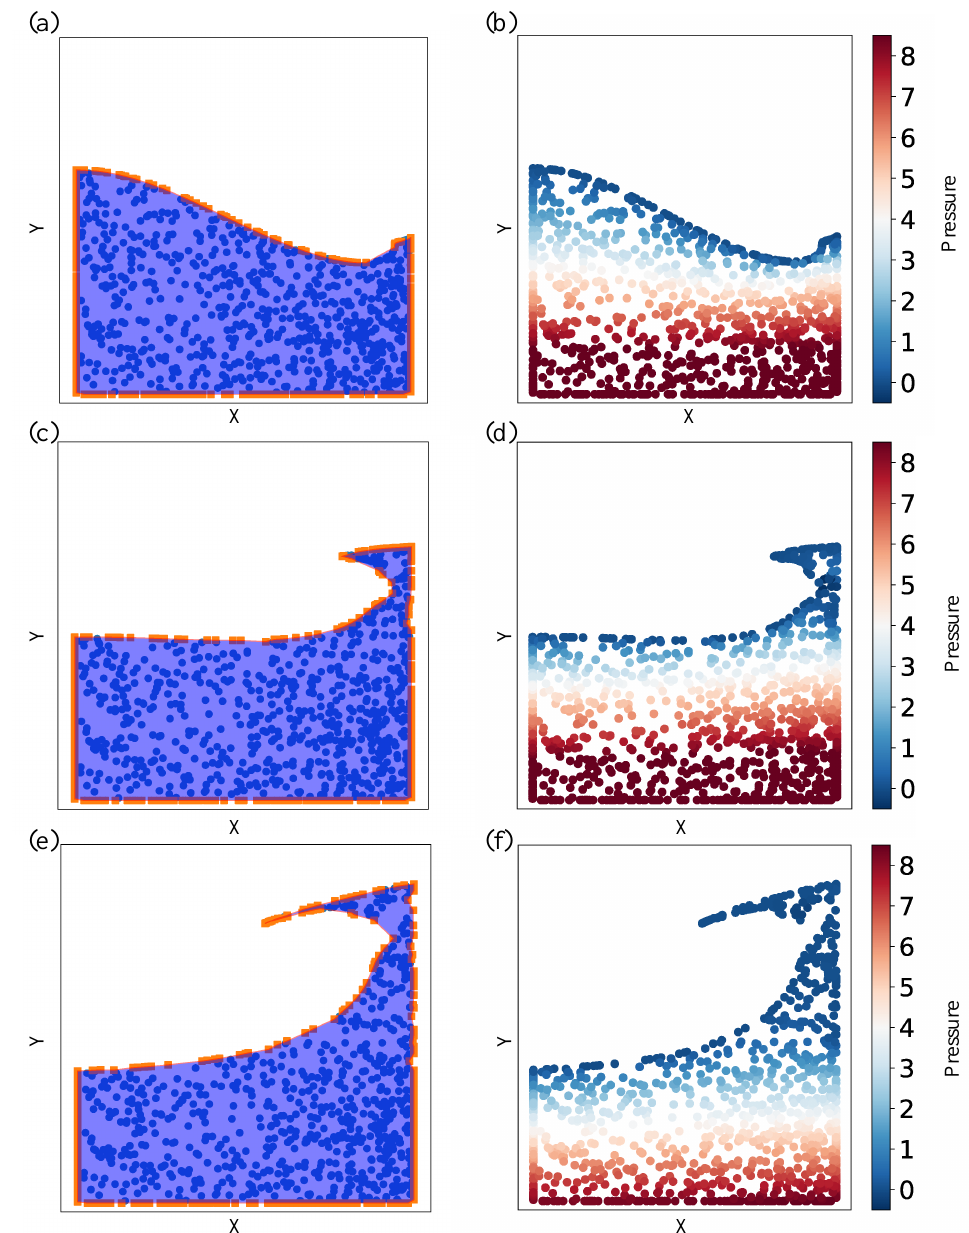
Figure 7. Surface particle identification and pressure field for violent sloshing with randomly distributed particles using the improved NPM. Simulation results at ( a , b ) t = 0.2 s; ( c , d ) t = 0.4 s; ( e , f ) t = 0.6